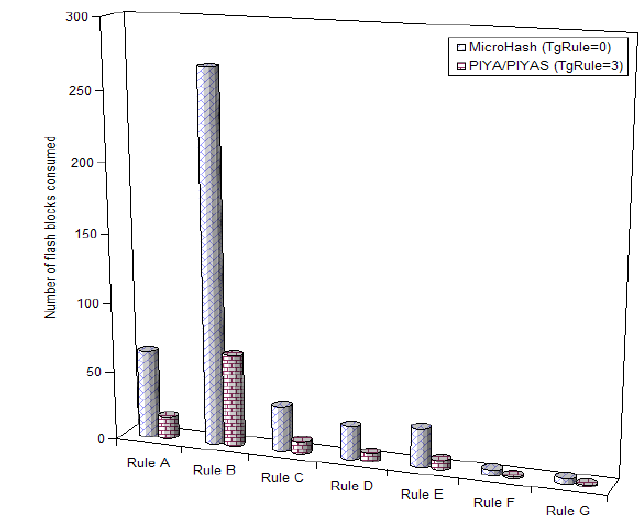
Figure 7. Flash memory consumption in number of erase